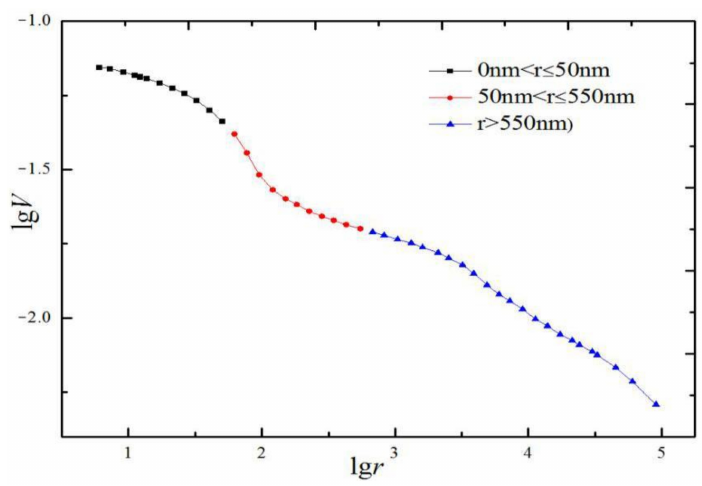
Figure 12. Relationship between Lg r and Lg V of OPC with compound admixture.